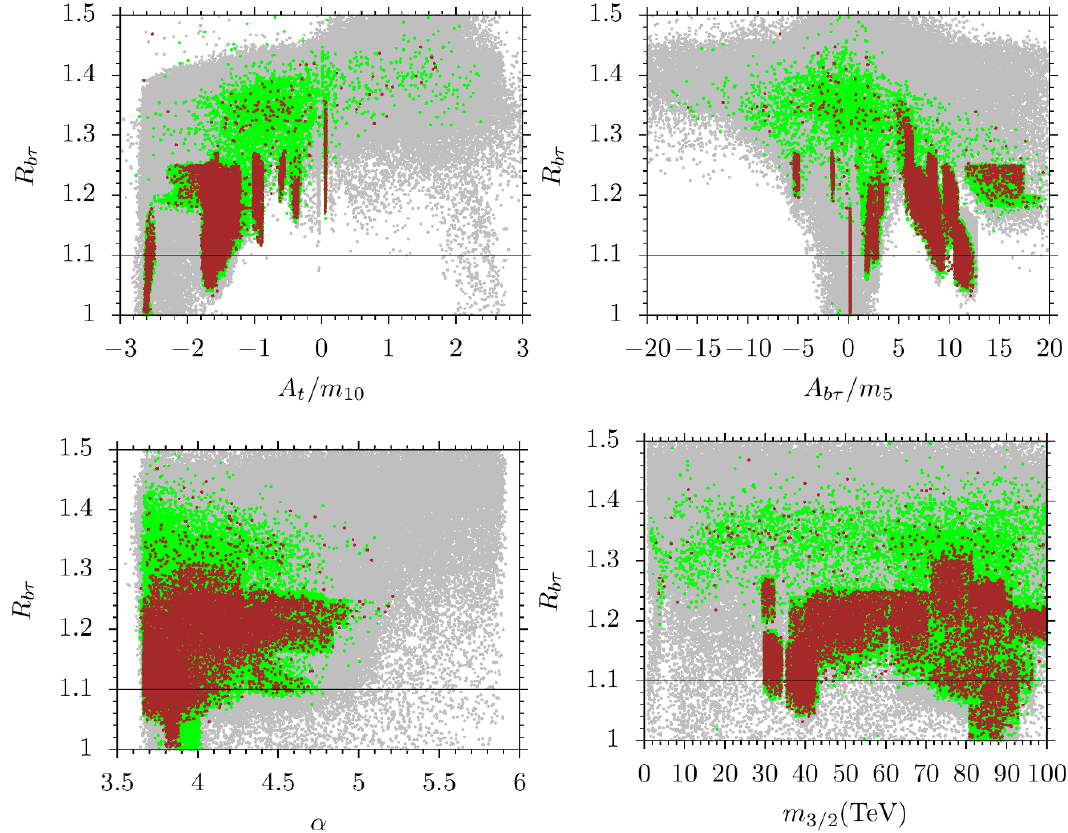
Figure 2 . Plots in the R b(cid:28) (cid:0) A t =m 10 , R b(cid:28) (cid:0) A b(cid:28) =m 5 , R b(cid:28) (cid:0) (cid:11) and R b(cid:28) (cid:0) m coding is the same as in (cid:12)gure